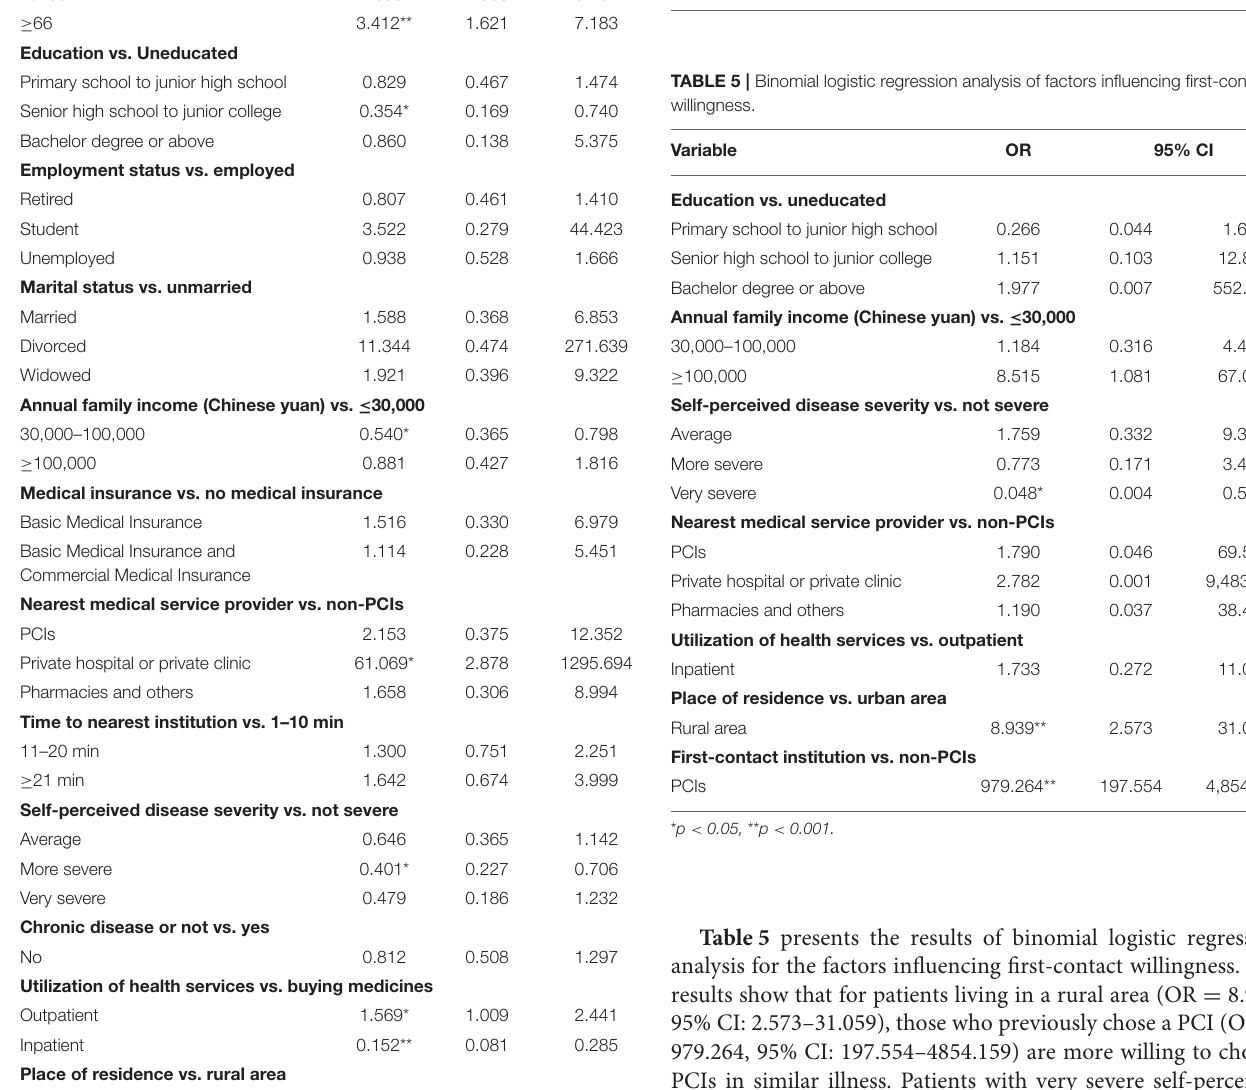
Table 5 presents the results of binomial logistic regression analysis for the factors influencing first-contact willingness. The results show that for patients living in a rural area (OR =